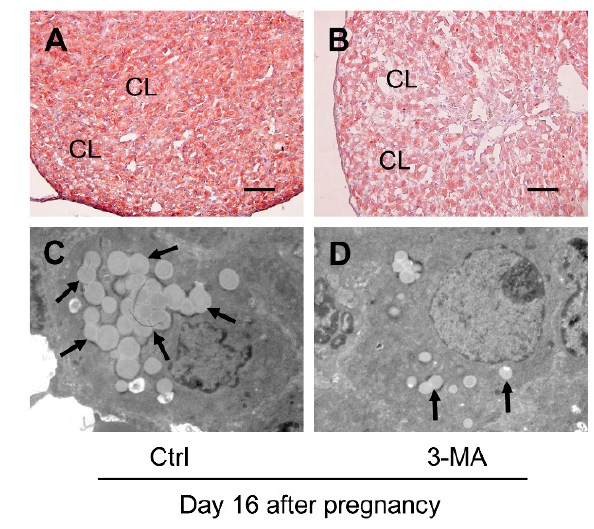
Figure 7. Effects of 3-MA on the storage of lipid droplets in ovaries on day 16 after pregnancy: ( A , B ) the storage of lipid droplets in ovaries on day 16 after pregnancy with and without 3-MA treatment by Oil Red O staining; ( C , D ) the storage of lipid droplets in ovaries on day 16 after pregnancy with and without 3-MA treatment by TEM observation. The arrow pointed to lipid droplets. CL: corpus luteum. Scale bar = 100 μ m.